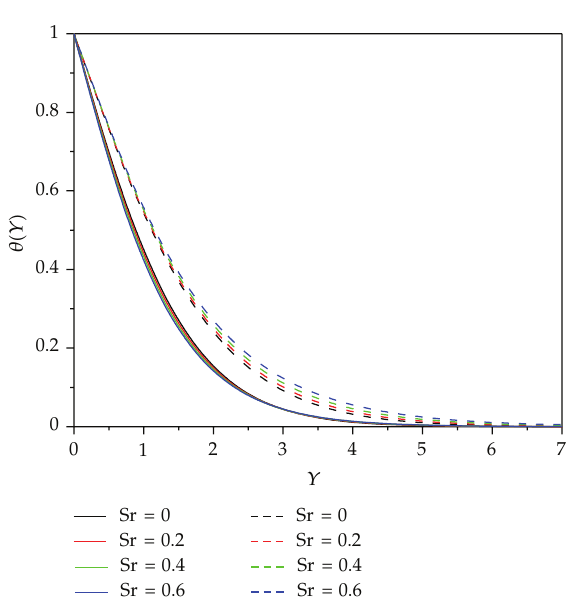
Figure 5: E ff ect of Sr on θ (cid:3) Y (cid:4) with D f (cid:10) 0 . 3, λ (cid:10) − 0 . 5 (cid:3) dashed lines (cid:4) , and λ (cid:10) 0 . 5 (cid:3) solid lines (cid:4) .